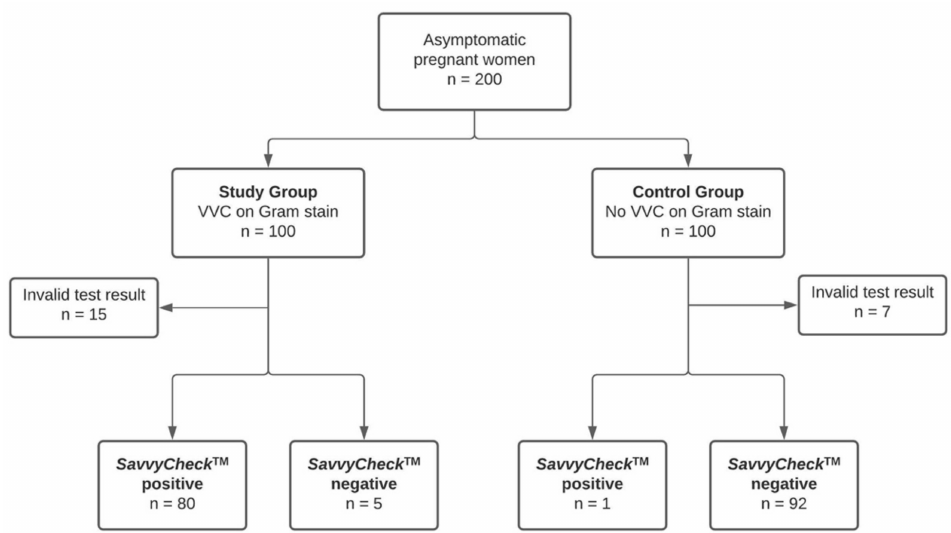
Figure 2. Criteria of inclusion of 200 enrolled, asymptomatic pregnant women who were screened for vulvovaginal candidosis (VVC) using Gram-stained smears and the SavvyCheck ™ Vaginal Yeast Test